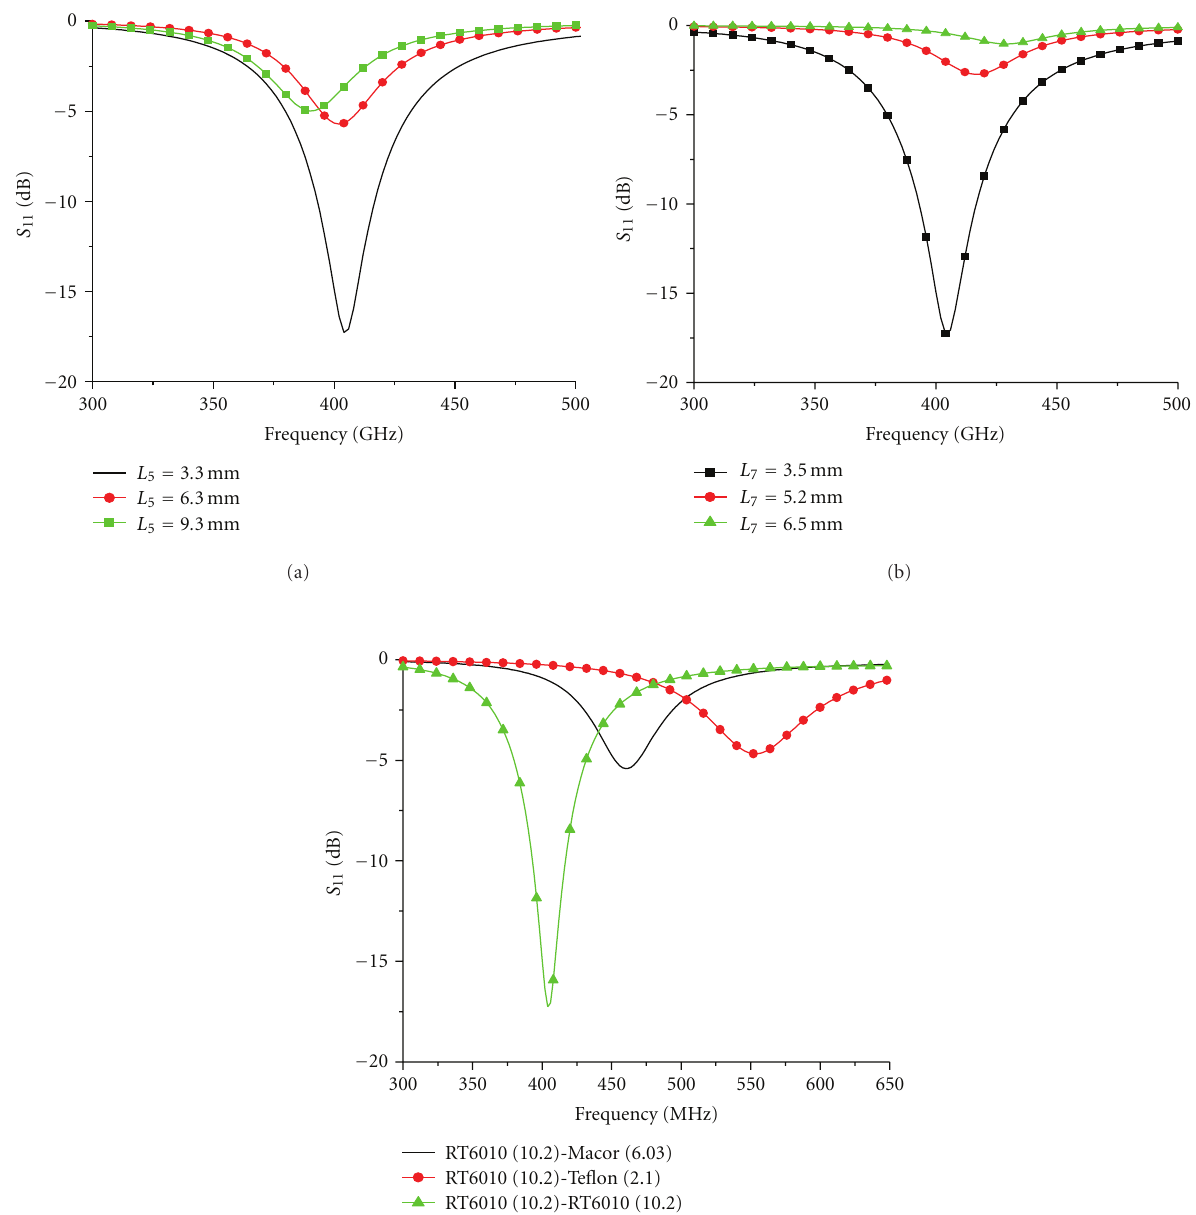
Figure 4: Parametric study of di ff erent (a) tail length, (b) shorting pin locations, and (c) combinations of substrate and superstrate.